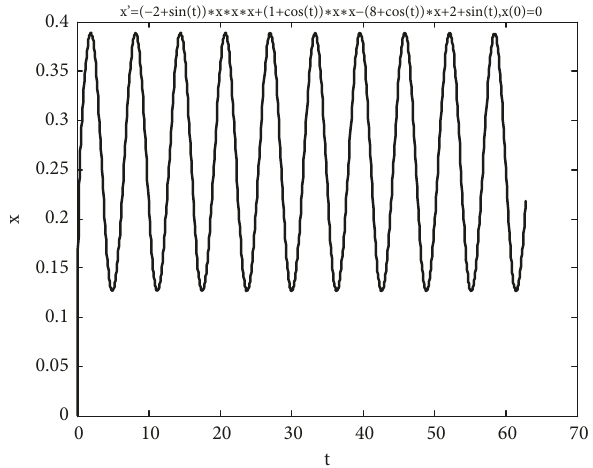
Figure 2: The solution curve of (75) with initial value 𝑥(0) = 0